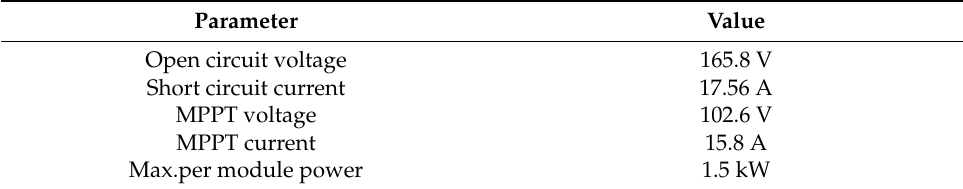
Table 2. Photovoltaic (PV) System